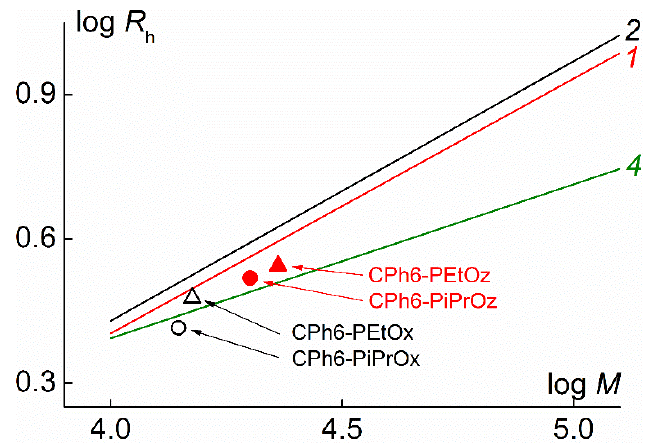
Figure 8. Hydrodynamic radius R h vs. M for the studied polymer stars in chloroform and MKHS dependences for linear PEtOx ( 1 [26] and 2 [59]) and star-shaped eight-arm C8A-PS ( 4 [53]).